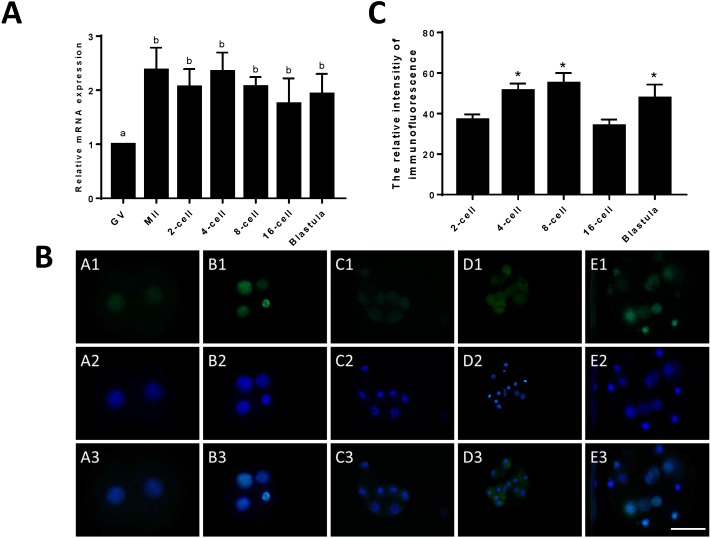
Relative expression of JARID2 in bovine oocytes and early embryos.(A) Relative expression of JARID2 mRNA in oocytes at the GV stage and embryos at the 2-cell, 4-cell, 8-cell, 16-cell and blastula stages. JARID2 is expressed at all oocyte and early embryonic stages, and its expression at the MII stage and early embryonic stages is significantly higher than that at the GV stage (p < 0.05). (B) Immunofluorescence localization of JARID2 protein in early embryonic development. In A1 ∼ E1, green FITC fluorescence represents the location of JARID2 protein at the 2-cell, 4-cell, 8-cell, 16-cell and blastula stages, and A2 ∼ E2 blue DAPI fluorescence represents the location of DNA in the cell nucleus. A3 ∼ E3 are the merged images. (C) The immunofluorescence intensity of JARID2 protein in early embryonic development. The results show that JARID2 is expressed at all stages of early embryonic development. Data are presented as the mean ± SD derived from triplicate transfectants of three independent experiments. Scale bar = 100 µm. Different superscripts (a and b) denote a statistically significant difference. ∗ denotes a statistically significant difference (p < 0.05).